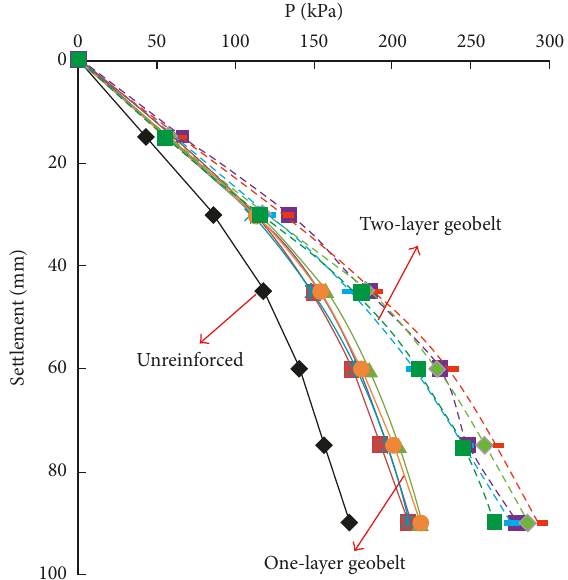
Figure 7: Pressure-settlement curves of cushions with and without geobelts.